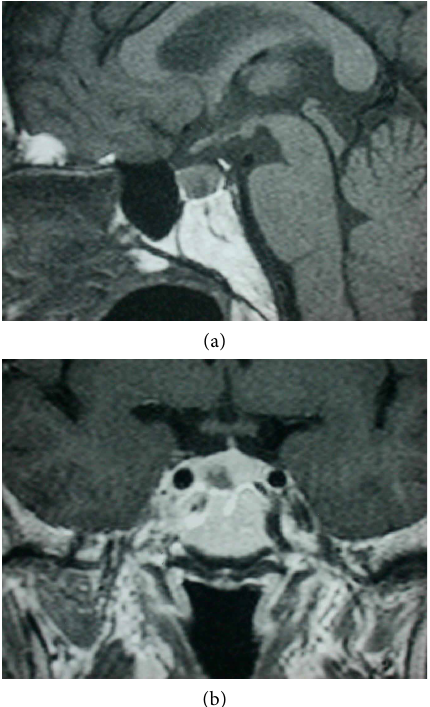
Figure 1: MRI pituitary gland (T1-weighted, sagittal view) showed a 6 mm hypointensity sellar lesion with irregular margin (a). On coronal postcontrast T1-weighted image, the lesion remained hypointensity while the gland showed marked homogenous enhancement (b).